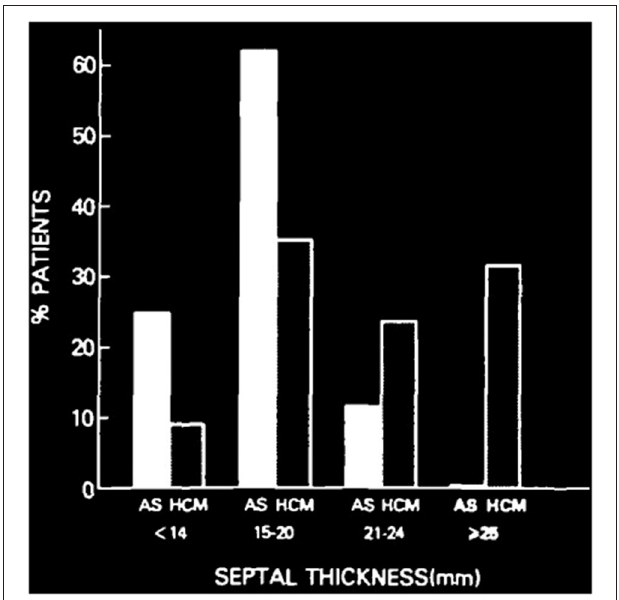
FIGURE 5 | Difference of ventricular septal thickness between valvular aortic stenosis and hypertrophic cardiomyopathy. Comparison of ventricular septal thickness in 85 patients with valvular aortic stenosis (AS) and 151 patients with hypertrophic cardiomyopathy (HCM), studied with echocardiography and at necropsy (